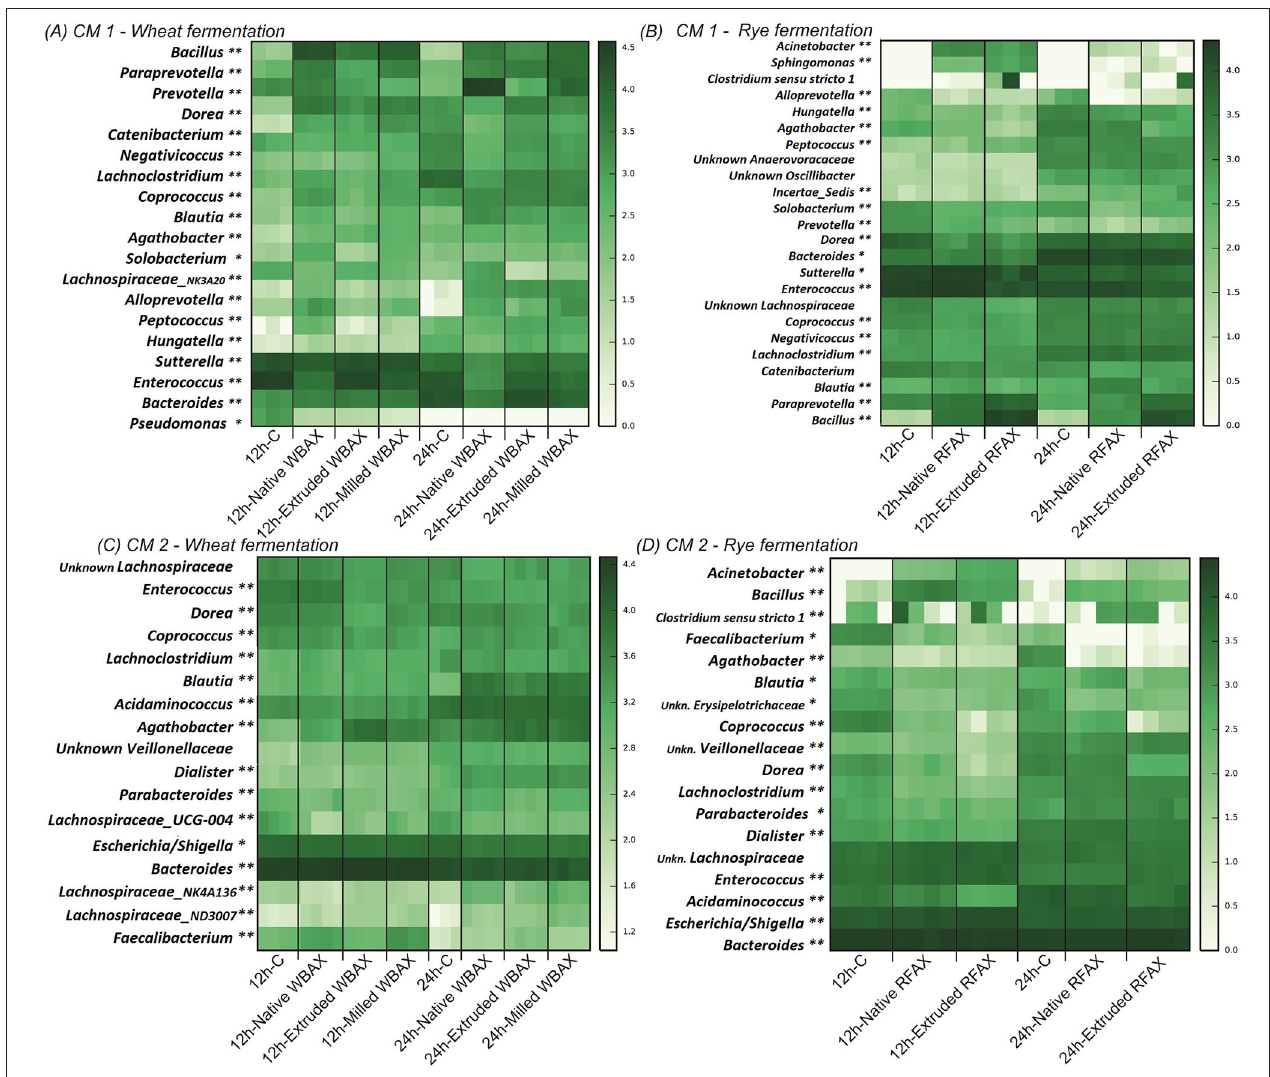
FIGURE 6 | Heatmap representing log-transformed absolute genus abundance ( > 1%) identified in CM 1 and CM 2 after 12 or 24h of fermentation of differently processed WBAX (A,C) and RFAX (B,D) , respectively. Genera for which abundance was significantly different between control and AX treatments at 12 and 24h (**) or only at 12 (*) or 24h (*) are indicated. Specific outcome of DESeq analysis is summarized in Supplementary Tables 7–10